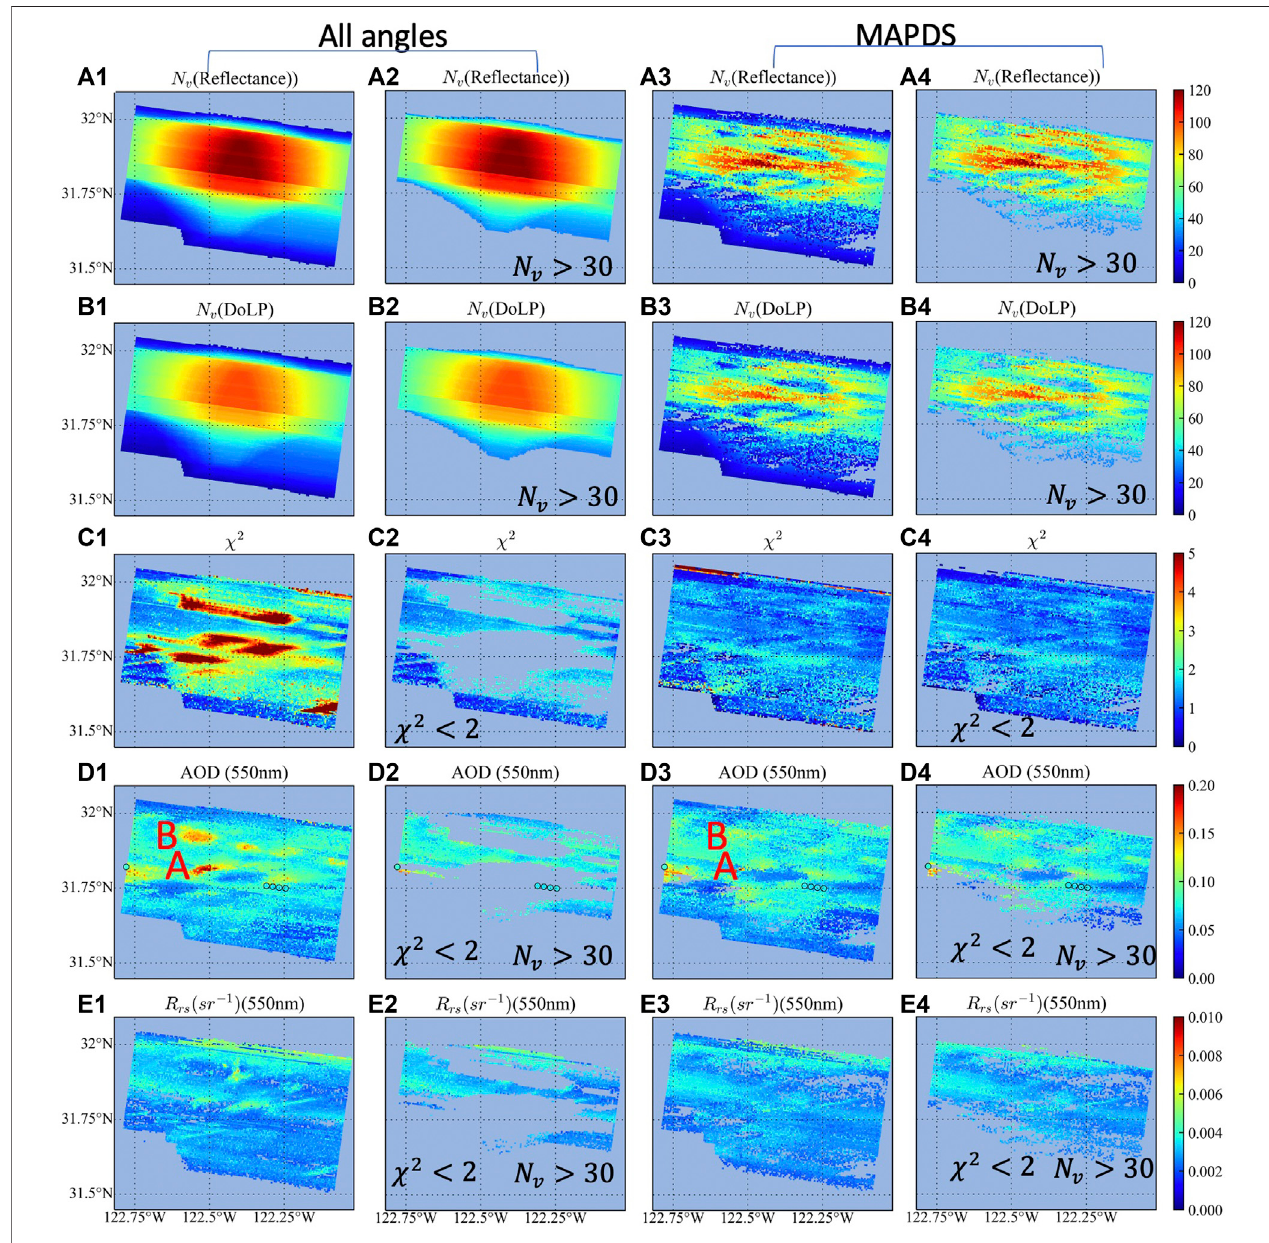
FIGURE8| RetrievalsontheAirHARPsceneover ocean withoutdatascreening(allangles, fi rstand secondcolumns)andwithMAPDS(third andfourth columns). Panelsshowthenumber ofviewingangles( N v )forthere fl ectance (A1 – A4) andDoLP (B1 – B4) ,retrievalcost function ( χ 2 , C1 – C4 ),retrieved AOD( D1 – D4 )andretrieved R rs ( sr − 1 , E1 – D4 ).The fi rstandthirdcolumnsshowallretrieved pixels;thesecondandthefourthcolumnsshowpixelsatisfyingcriteriaof N v > 30and χ 2 < 2,respectively. The HSRL AOD at 532 nm is indicated as colored dots in the AOD plots (D1 – D4) . Same as Figure 6 , two cloud patches are indicated by A and B.